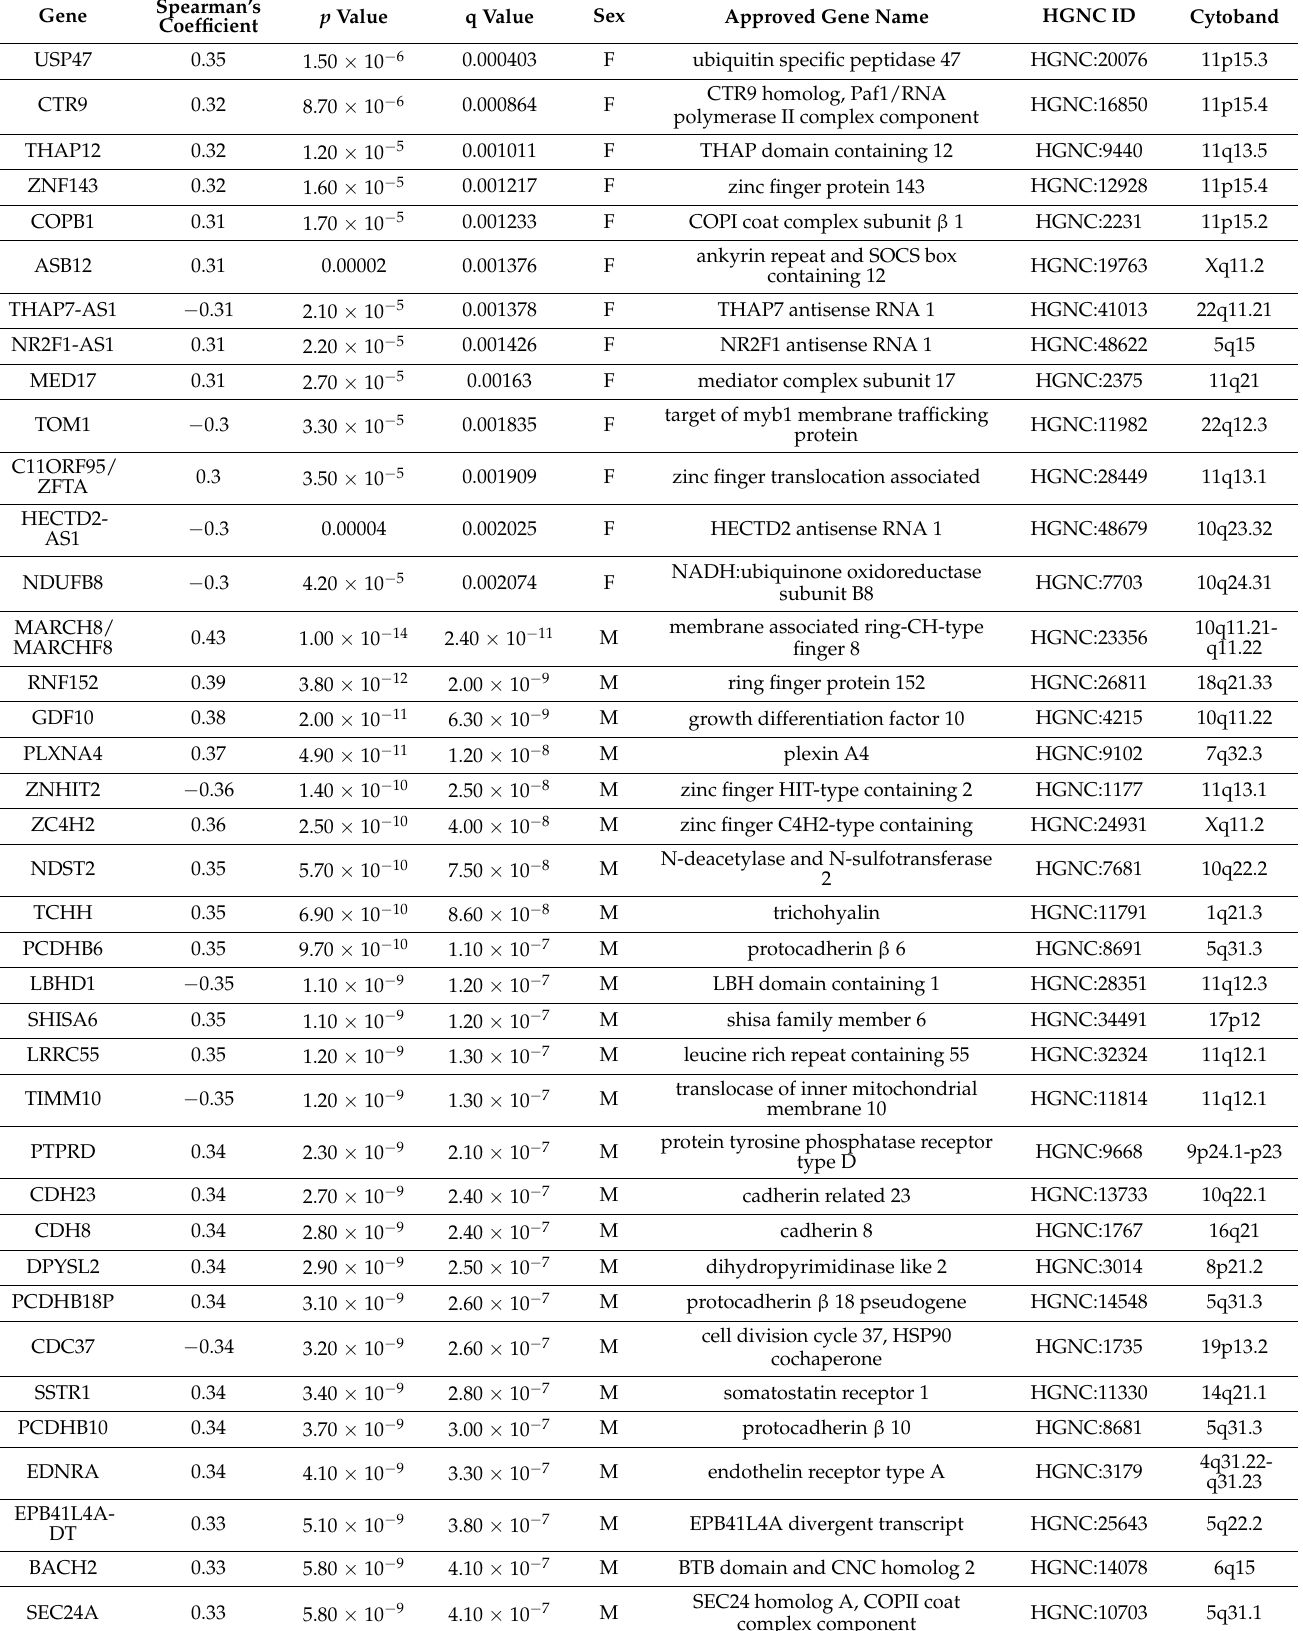
Table A2. Sex-specific AR co-expressed genes in